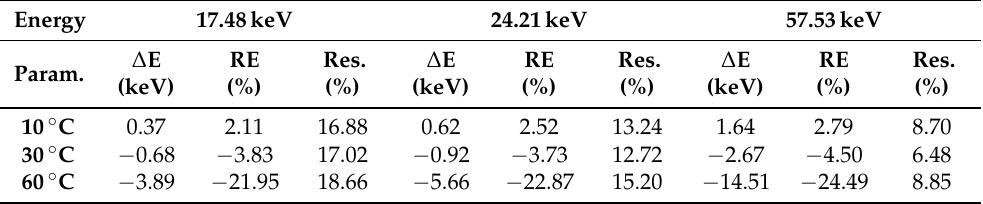
Table 3. Temperature influence on radiation energy measurement with 500µm silicon MiniPIX Timepix3 detectors in Time-over-Threshold mode. Where ∆ E is the absolute measurement accuracy, RE is the relative error of measurement, and Res. is the relative energy resolution. Energy 17.48keV 24.21keV 57.53keV ∆ E ∆ E ∆ E RE Res. RE Res. RE Res. Param. (keV) (%) (%) (keV) (%) (%) (keV) (%) (%) 10 ◦ C 0.37 2.11 16.88 0.62 2.52 13.24 1.64 2.79 8.70 0.68 3.83 17.02 0.92 3.73 12.72 2.67 4.50 30 ◦ C − − − − − − 3.89 21.95 18.66 5.66 22.87 15.20 60 ◦ C − − − −